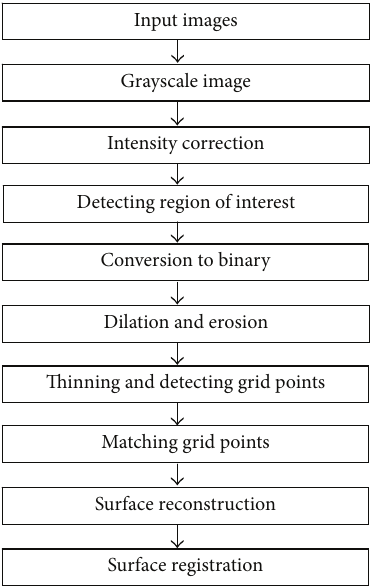
Figure 2: Flowchart for automatic fusion of intraoperative endo- scopic images to preoperative